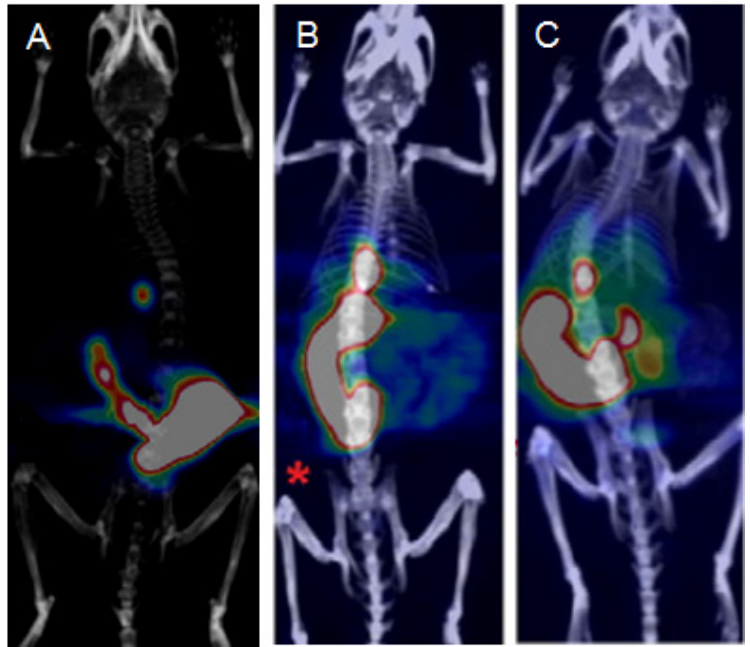
Figure 4. In vivo PET/CT images presenting the whole body biodistribution of [ 18 F]FTZ-PCur ( A ), PA-mApoE-[ 18 F]FTZ-PCur-NLs ( B ), and TZ-PCur-mApoE-[ 18 F]FTZ-PCur-NLs ( C ). Figures present summed PET images taken 30–60 min after injection into a wild-type (WT) mouse. Figure has been obtained by merging and elaborating images drawn from references [36,39]. Reprinted with permission from [36,39]. Copyright 2016 Elsevier.